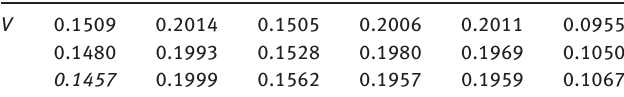
Table 10: The Weights of HFEs.